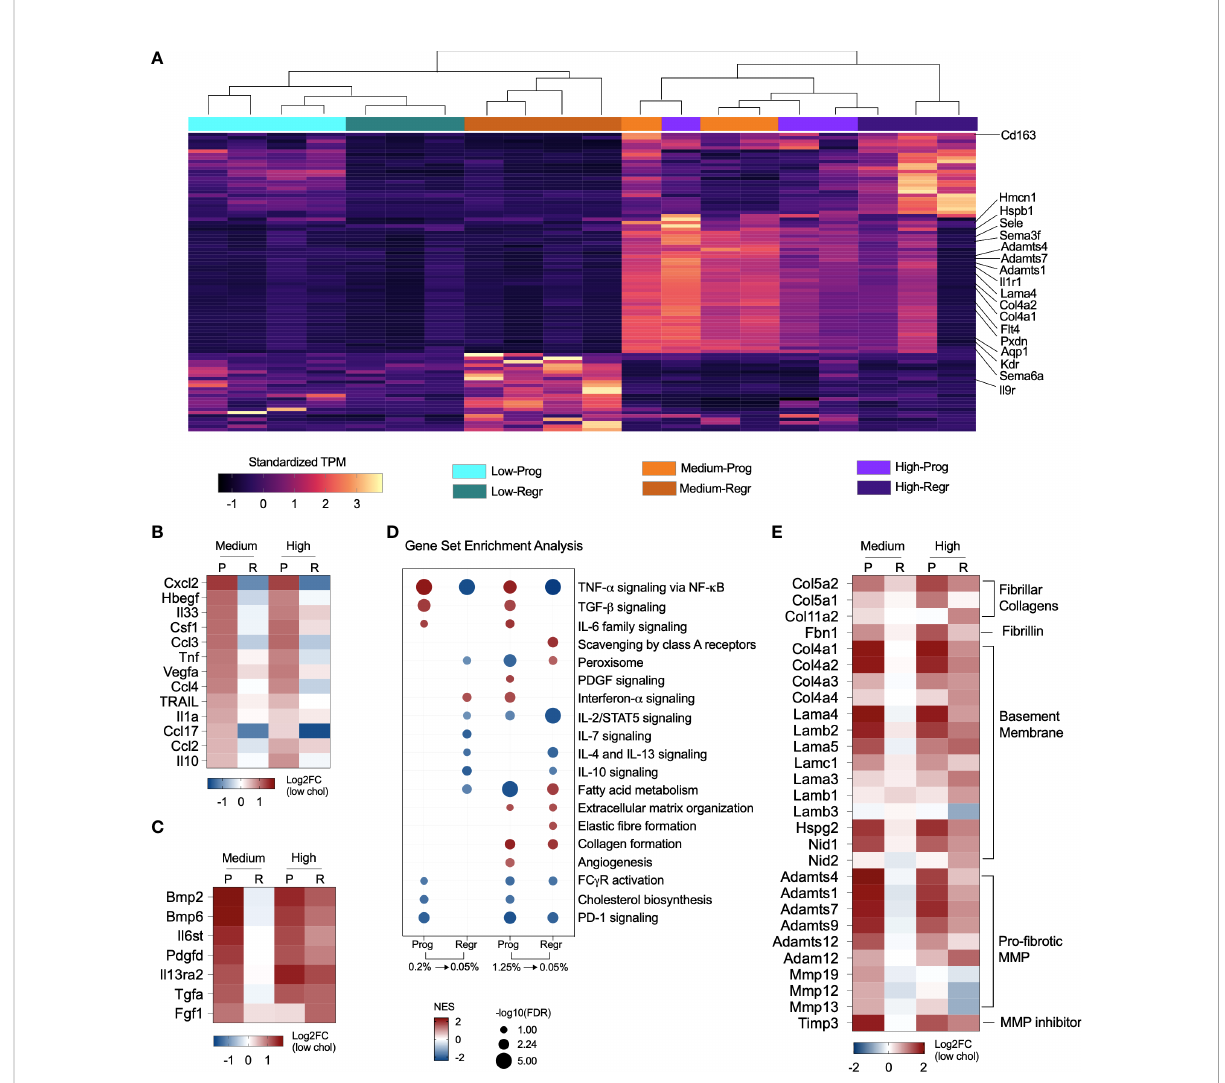
FIGURE 5 Cholesterol triggers expression of pro- fi brotic and pro-in fl ammatory genes. (A) Heatmap shows the standardized gene expression values of the 25 top upregulated genes found in each group. The highlighted genes commonly upregulated in the medium and high cholesterol groups during progression phase (Prog) and in the high cholesterol groups during regression phase (Regr) are mainly related to extracellular matrix organization, angiogenesis, and cell migration. (B) Expression of several cytokines relevant to NASH are affected by dietary cholesterol. In general, these cytokines were upregulated due to increased cholesterol dietary content and show an attenuated expression pattern after cholesterol reduction. (C) Cytokines upregulated during progression phase in both cholesterol groups and that maintained high expression in the high cholesterol groups after cholesterol reduction. Genes normalized in the medium cholesterol group during regression phase. (D) Gene Set Enrichment Analysis results, based on Hallmark and Reactome databases, highlighted the upregulation of TNF- a , TGF- b , and IL-6 signaling pathways during the progression phase of both cholesterol groups with subsequent downregulation/normalization after cholesterol reduction. The pathways for IL-10, IL-4/IL-13 signaling were downregulated by cholesterol reduction in both groups. Lipid metabolism, FC- g receptor activation and PD-1 signaling are inhibited in both groups in the progression phase. The high cholesterol group showed continuous upregulation of collagen formation in both progression and regression phases. (E) Heatmap showing the fold changes in the expression of fi brillar collagens, fi brillin, type IV collagen and laminin, other basement membrane components, and pro- fi brotic proteases. Gene expression was upregulated in medium and high cholesterol groups during progression phase and stayed elevated in the high cholesterol after cholesterol reduction. P or Prog, Progression phase; R or Regr, Regression phase; Log2FC, log2-foldchange based on low cholesterol age-matched